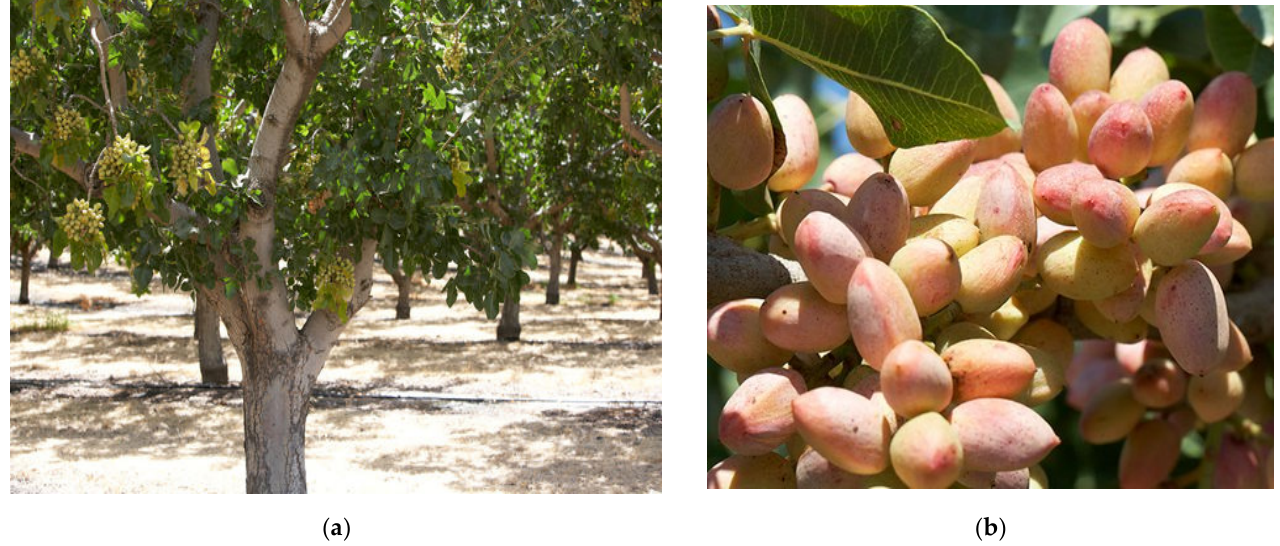
Figure 1. Fruit-bearing Pistacia vera L. Kerman cultivar ( a ); Pistacia vera L. ripe fruit (hull) ( b ).